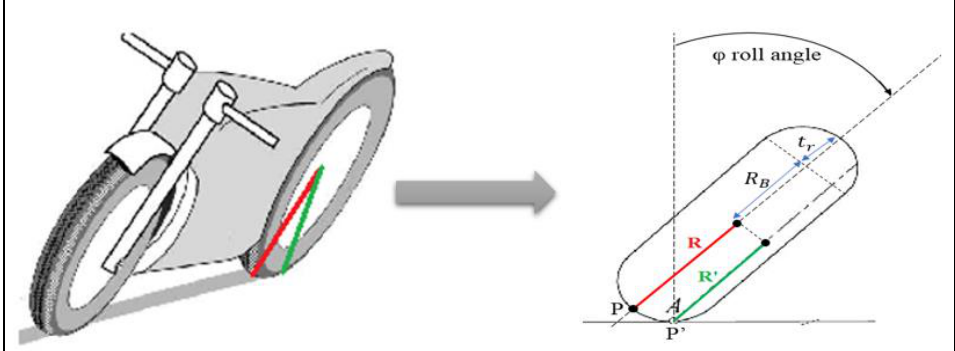
Figure 6. Lateral displacement of the rear contact point in a curve.